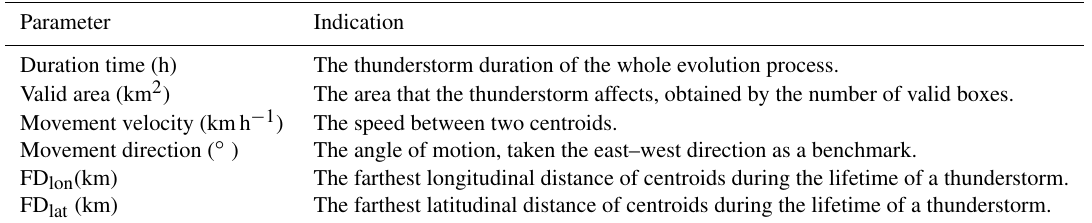
Figure 3. (a) Illustration of the eight-adjacent connected-neighbourhood labelling and the procedure of dealing with the lightning data to obtain the centroid and the valid area of clusters. (b) The workflow of cluster identification through density maps. Table 1. Five parameters to characterise the motion of